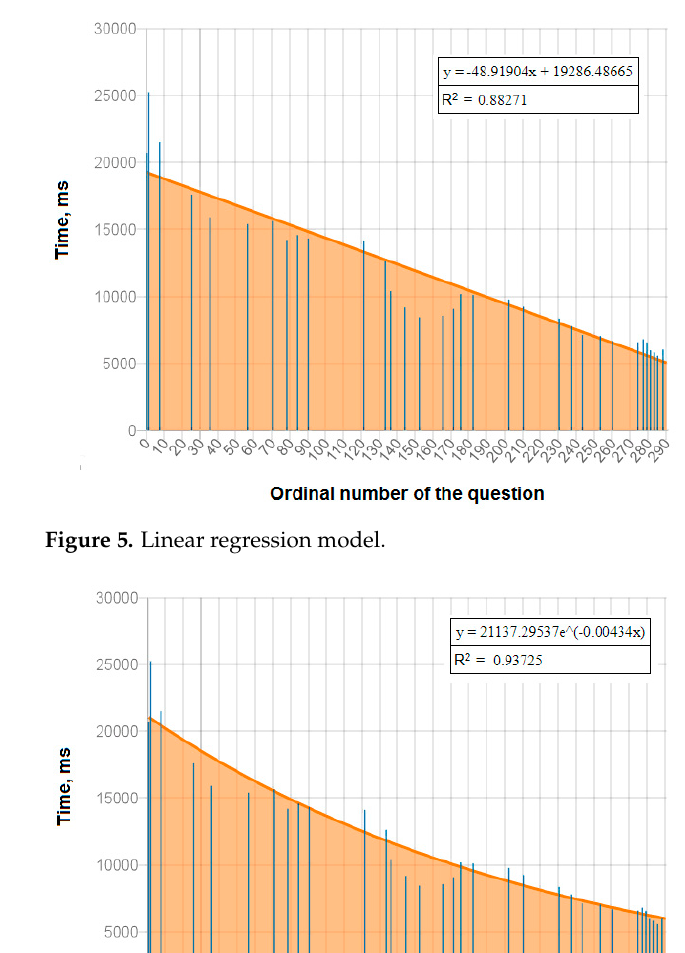
Figure 4. Reaction time of particular respondents to the questions with the delay due to possible distraction.